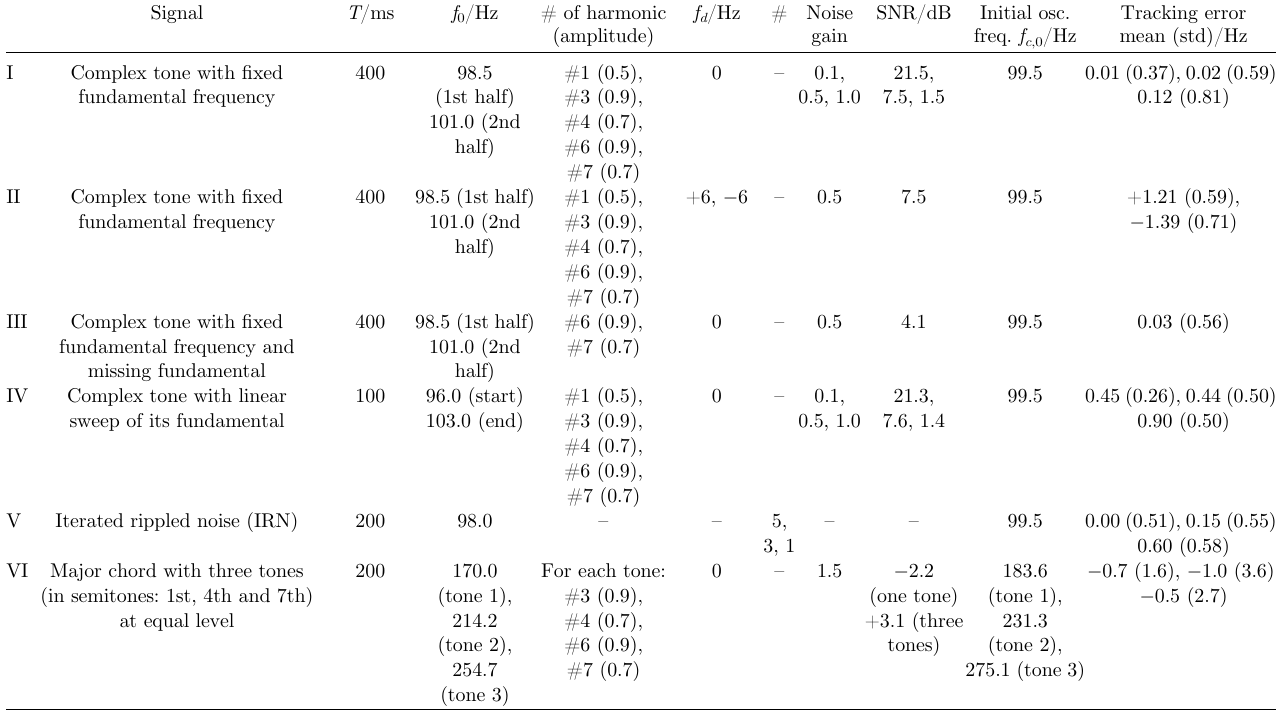
Table 1. List of simulations performed. 1st col.: Simulation number; 2nd col.: Brief signal description; 3rd col.: Total signal duration; 4th col.: Fundamental frequency; 5th col.: Composition of each complex tone (number of harmonic and its amplitude, n/a for IRN); 6th col.: Amount of mistuning of all components (simulation II only); 7th col.: Number if iterations of the IRN (simulation V only); 8th col.: Gain of additive Ν (0, 1)-distributed Gaussian noise; 9th col.: Signal-to-Noise Ratio computed across the whole signal duration (n/a for IRN); 10th col.: Initial PM-HLL oscillator frequency: 11th col.: Tracking error in terms of mean and standard deviation across the whole signal duration, excluding the time period of initial convergence (cf. Sect.